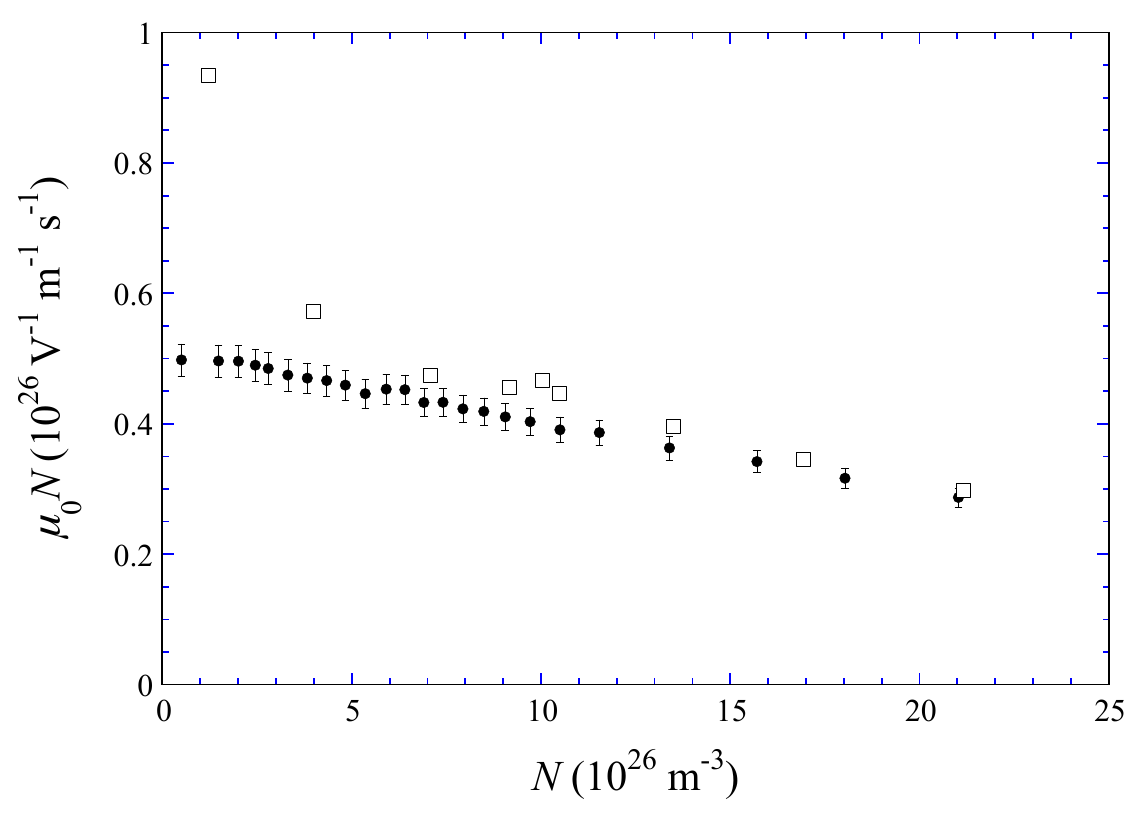
77K. Comparison of the present measurements accuracy at T = 77.2K (closed points) with Figure 1. µ 0 N vs. N at T ≈ literature data at T = 77.6K (open squares)